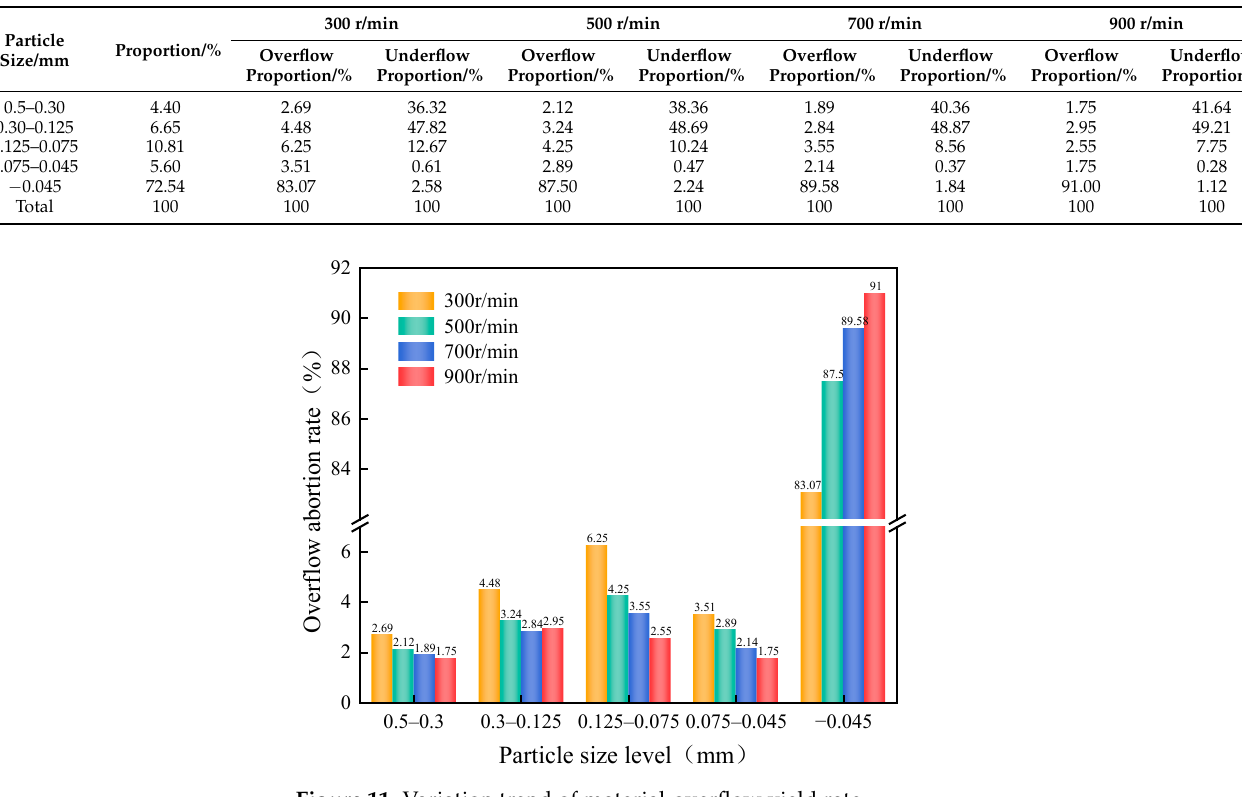
Table 4. Separation results of materials at different rotational speeds.